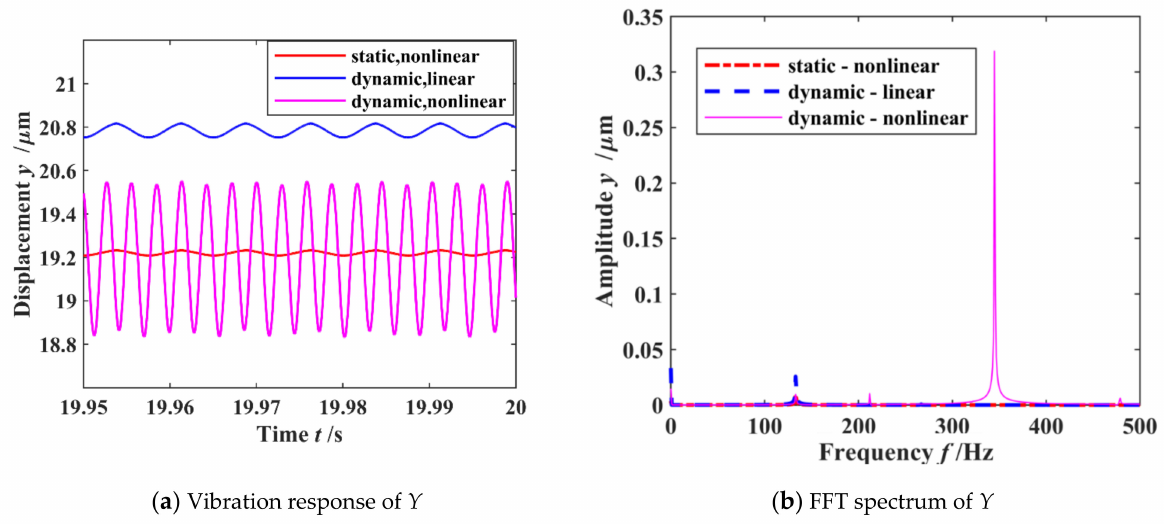
Figure 6. Vibration response in time-domain and